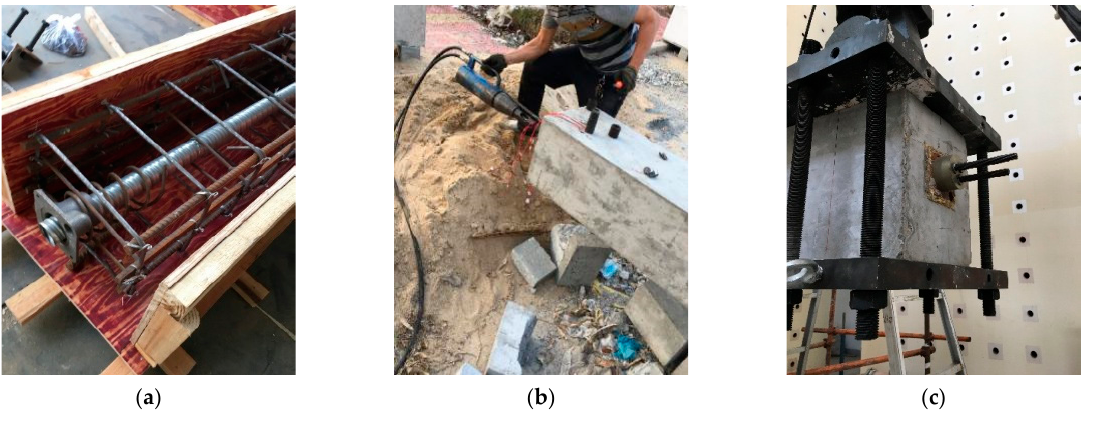
Figure 3. Post-tensioning tendon construction: ( a ) embedding corrugated duct; ( b ) prestress wire tensioning; ( c ) prestress wire anchorage. tensioning; ( c ) prestress wire